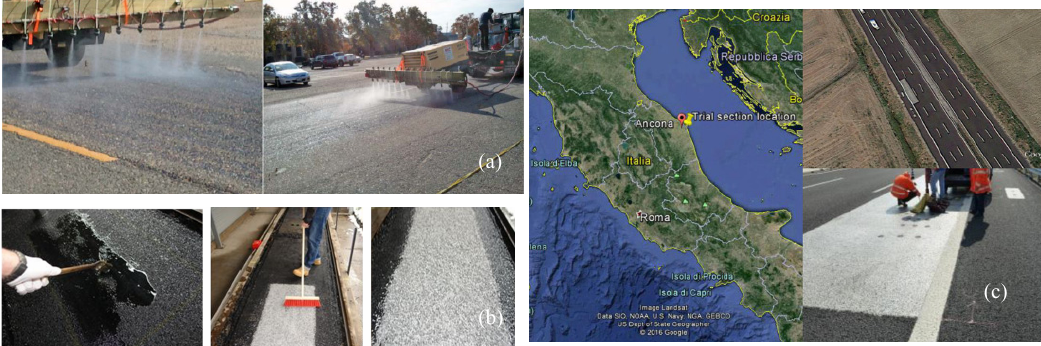
Figure 6. Photocatalytic test sections: ( a ) by Hassan et al. (Reprinted with permission from [9]